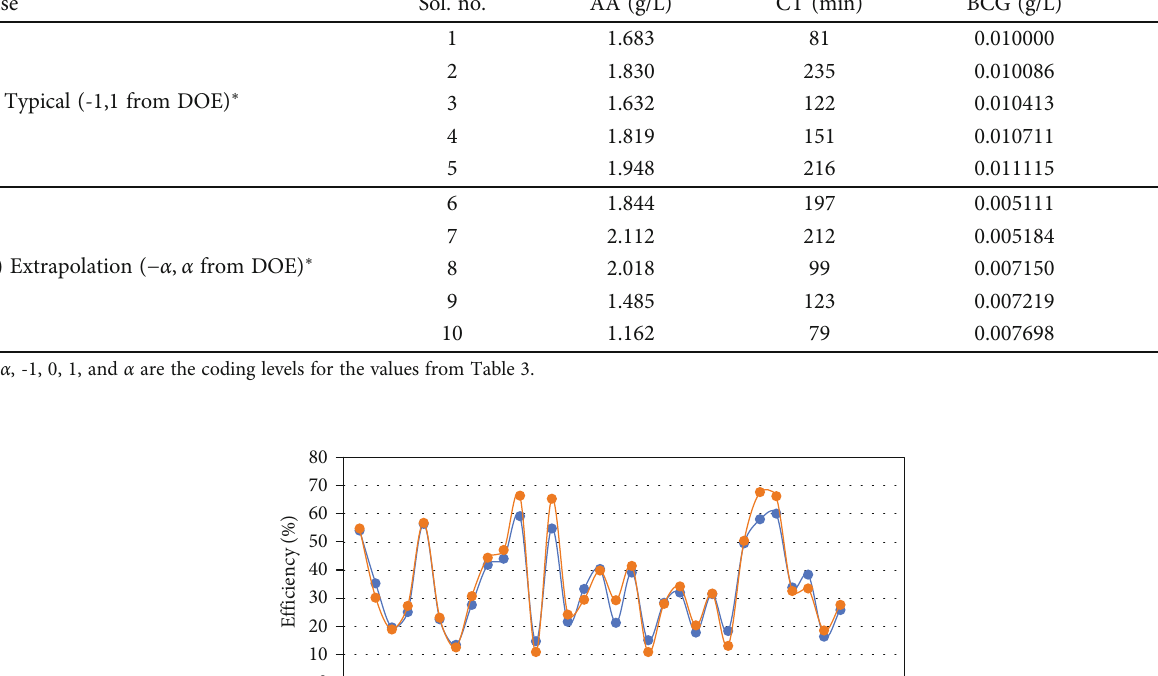
Table 5: Optimization results obtained with BFO and RSM for typical and extrapolation cases. Case Sol. no.